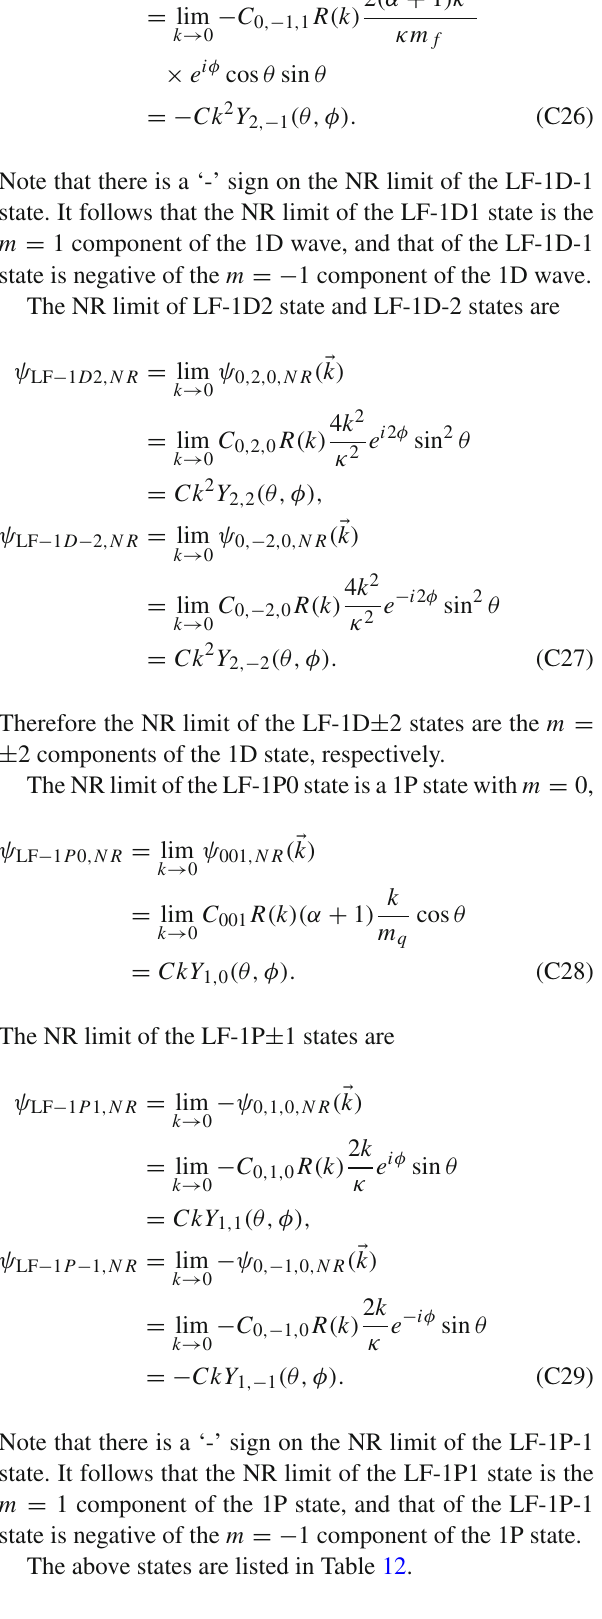
Table 12 The NR limit of the LF spectroscopic states in comparison with the spherical harmonics states ψ LF − W By design